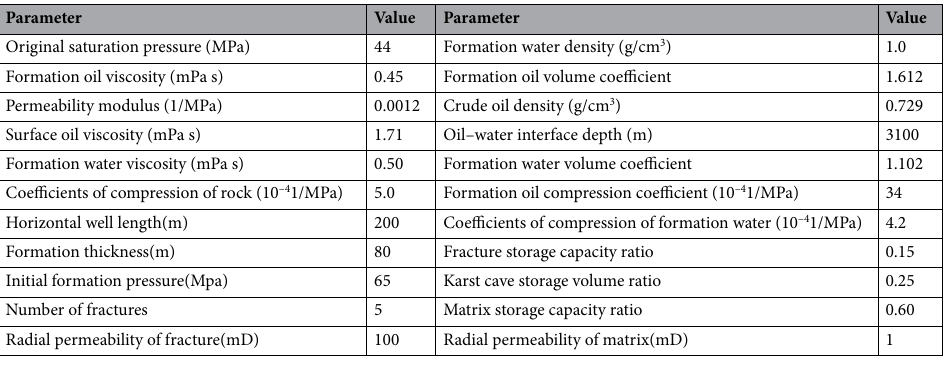
Table 3. Basic reservoir